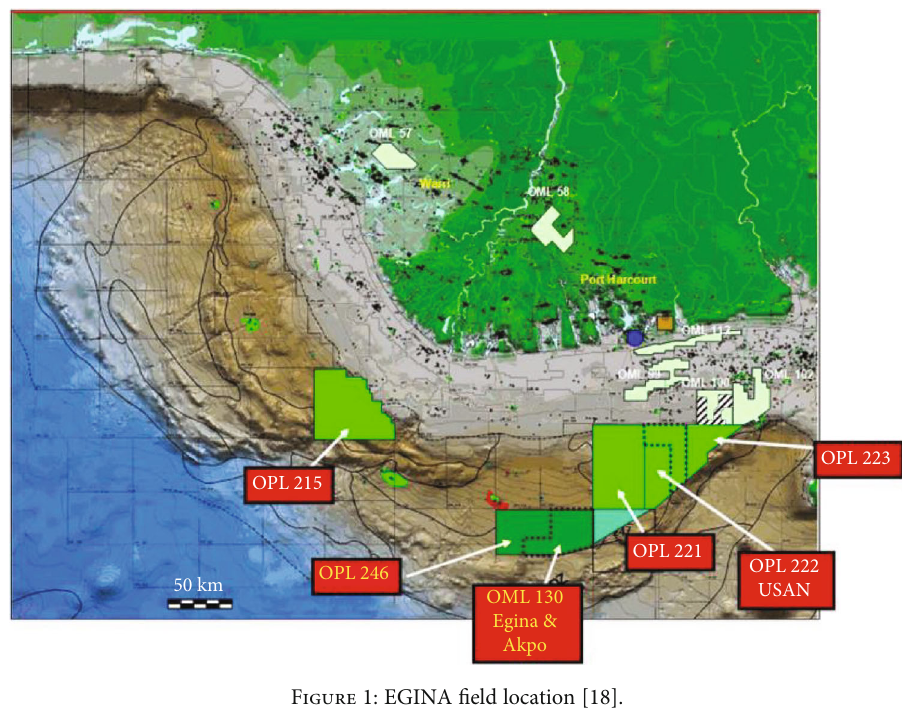
Figure 1: EGINA fi eld location [18].